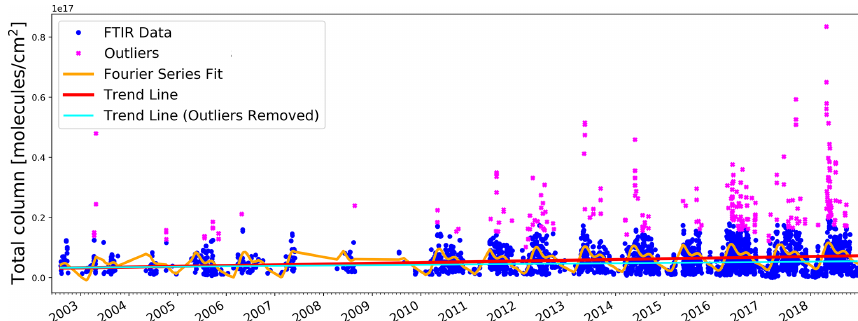
Figure 1. Time series of TAO FTIR NH 3 total columns from 2002 to 2018 with third-order Fourier series fit and linear trends.